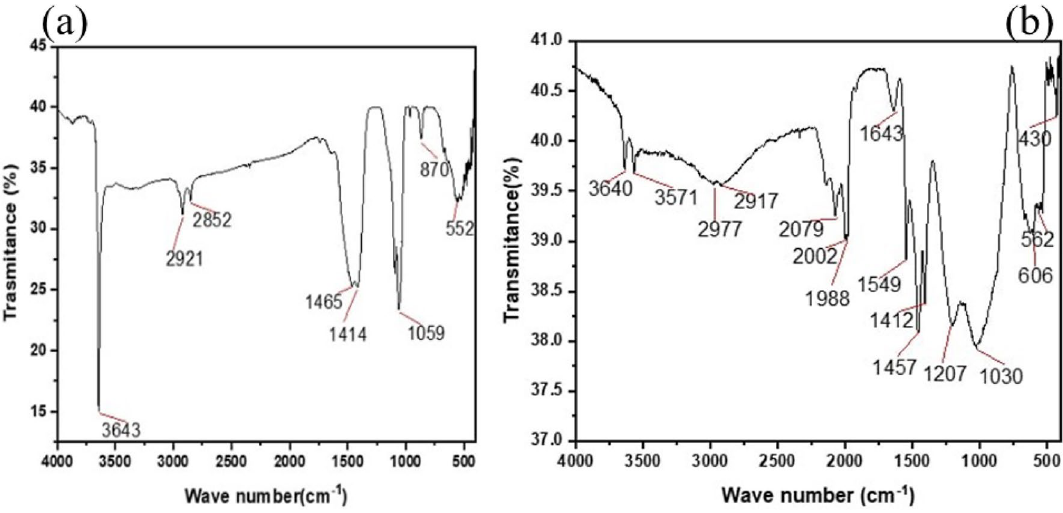
Figure 2. FTIR Spectrum of limestone pattern of ( a ) CaO and ( b ) Zn-doped CaO